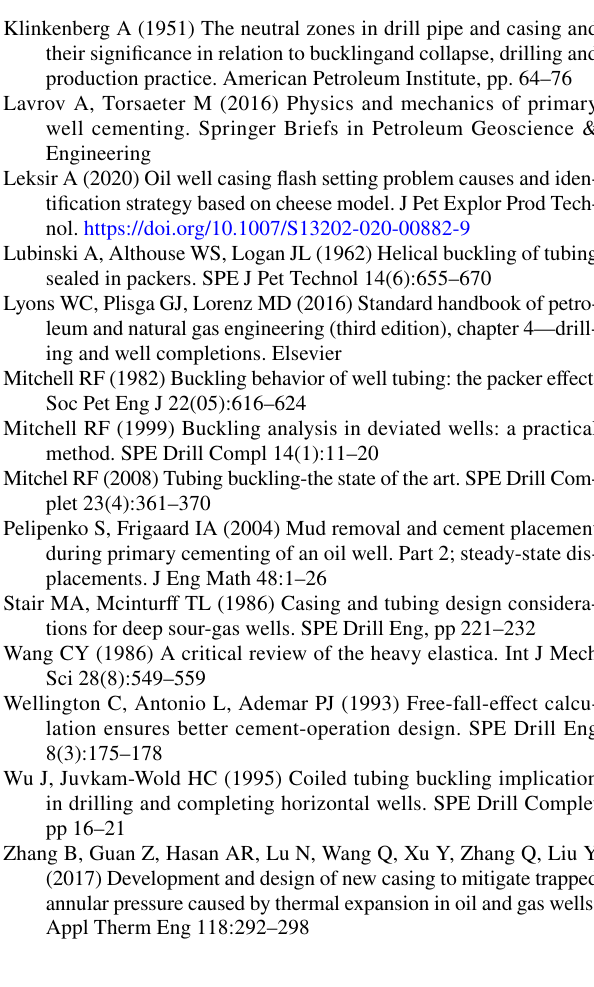
cement program, real job and the occurrence of buckling